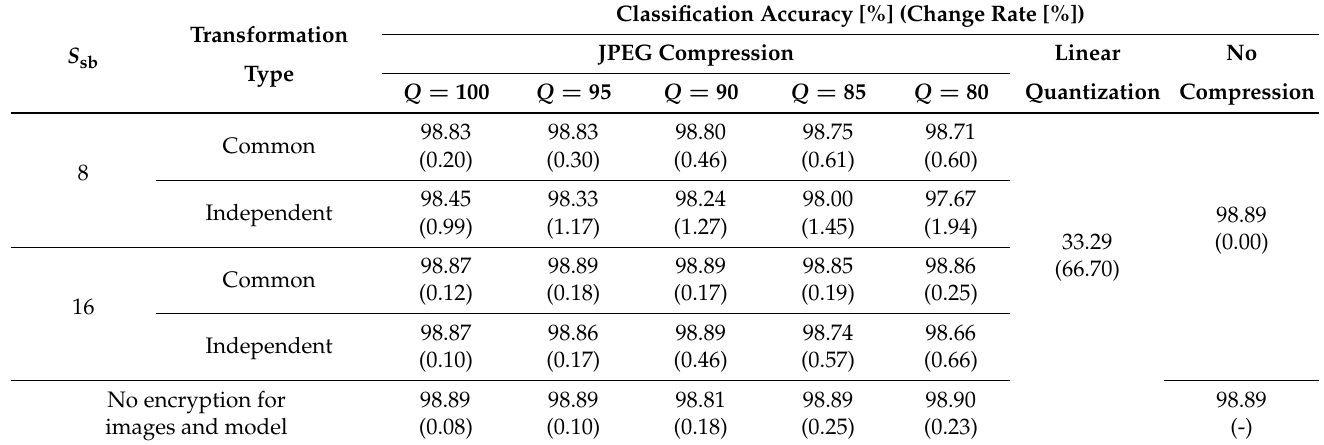
Table 2. Classification accuracy and change rate for scheme